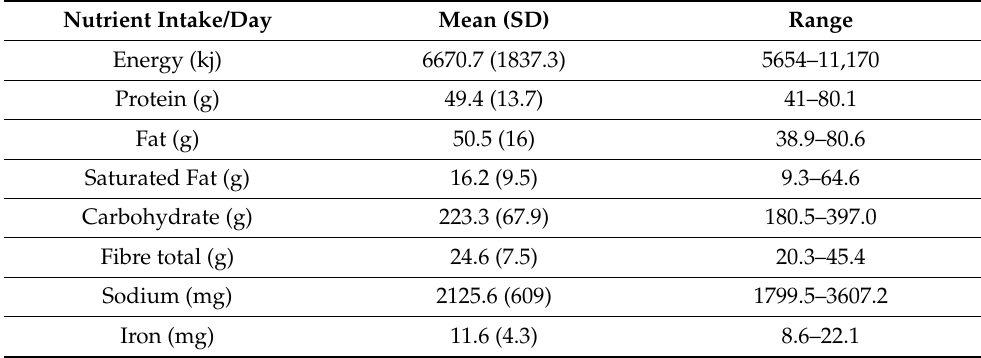
Table 4. Mean daily intakes using FoodWorks ( n =